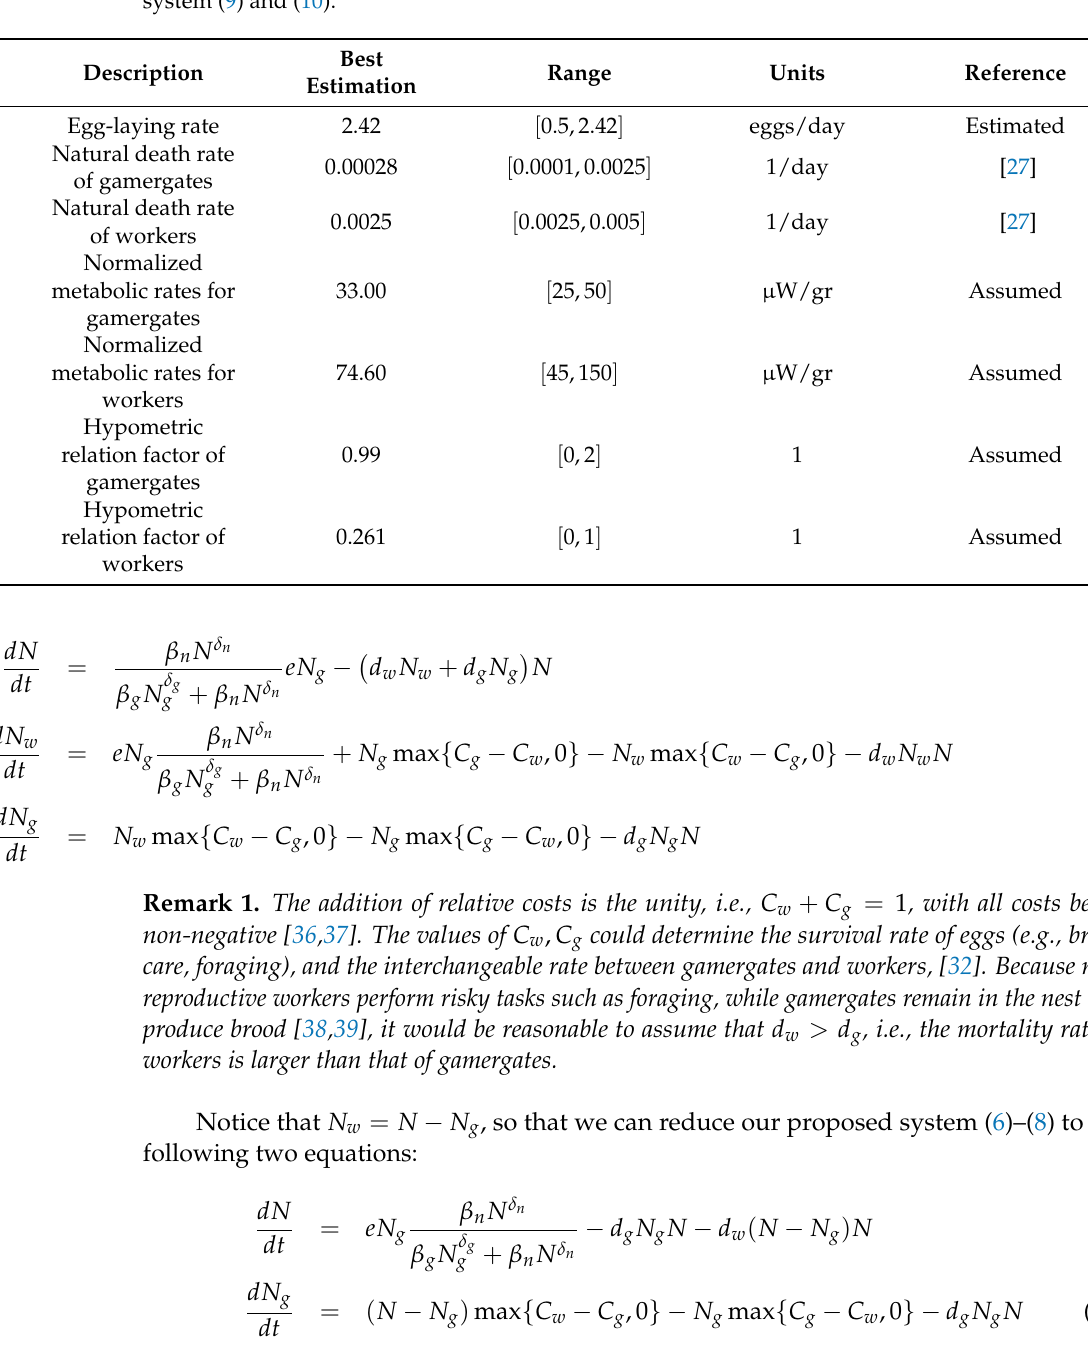
Table 1. Biological meanings, best-fit values, ranges, and references for the parameters of the system (9) and